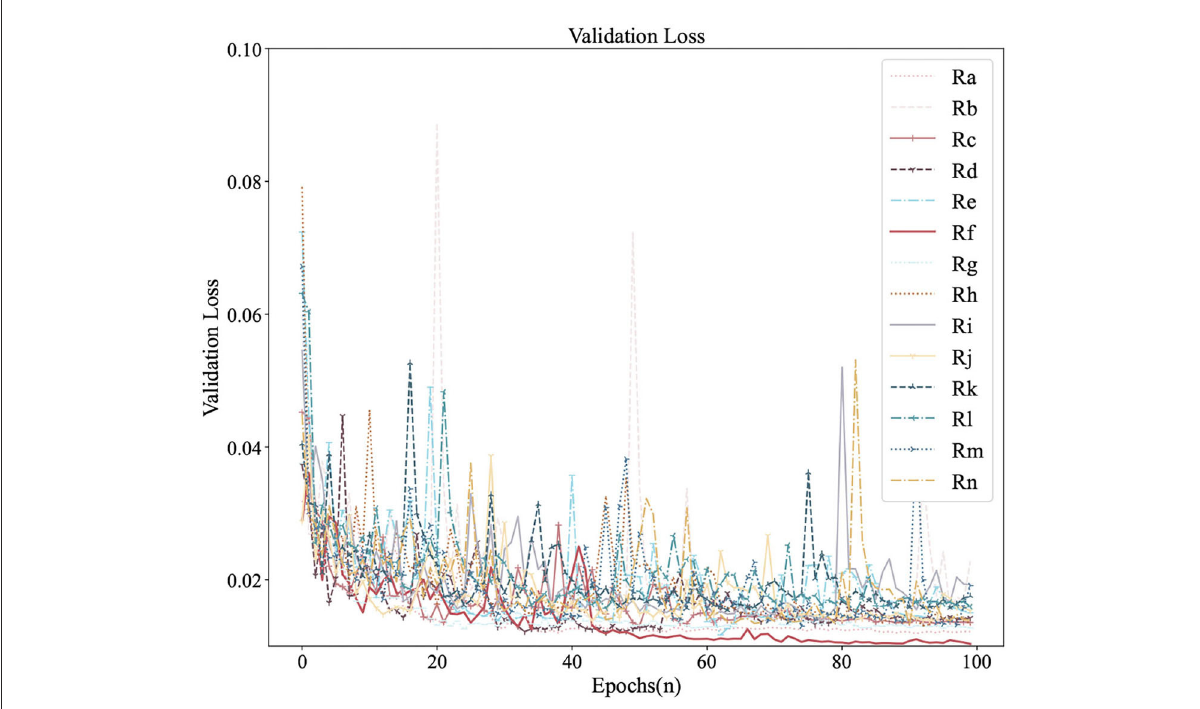
FIGURE6 Comparison of Rotate Loss among 14 regressors on the